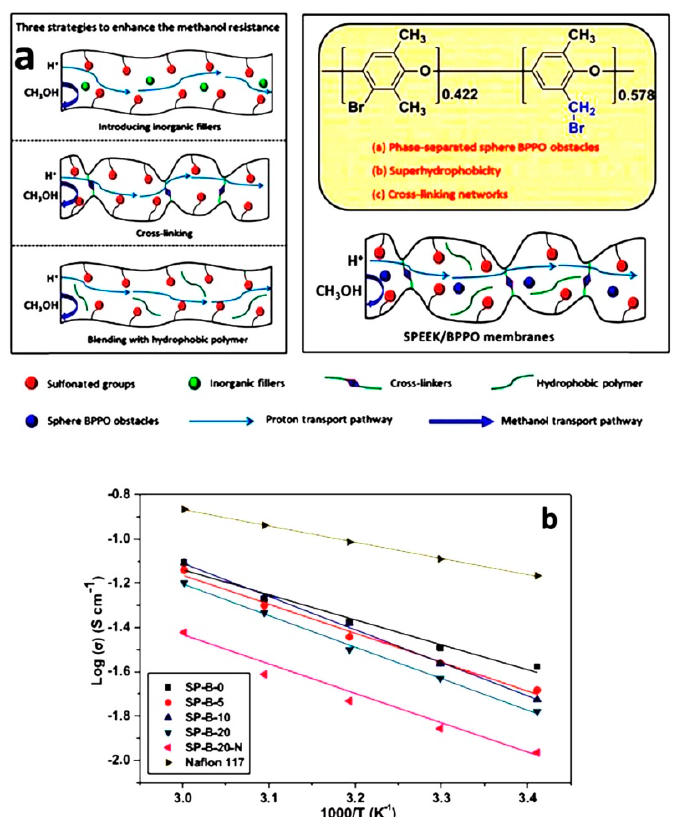
Figure 6. ( a ) Schematic illustration of BPPO’s functions of the super hydrophobic BPPO filler toward the neat methanol operation of DMFC. ( b ) Proton conductivity of SPEEK / BPPO blend membranes. Reproduced with permission from [59]. Copyright Elsevier, 2017.